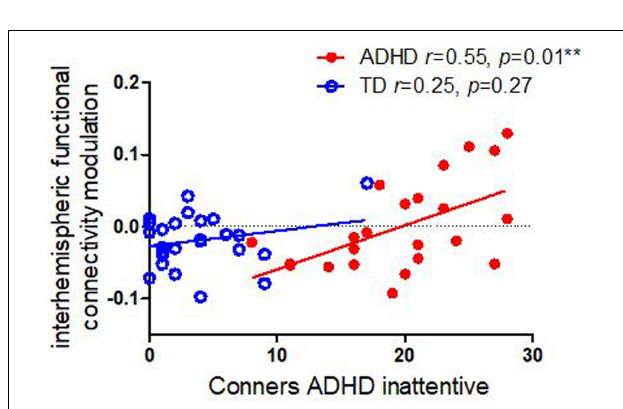
FIGURE 3 | Correlations between interhemispheric functional connectivity modulation in alpha and Conners ADHD inattentive and H/I symptoms in children with ADHD and TD controls. Children with ADHD showed an association between inattentive symptom severity and task-related modulation of connectivity, whereas the TD cohort did